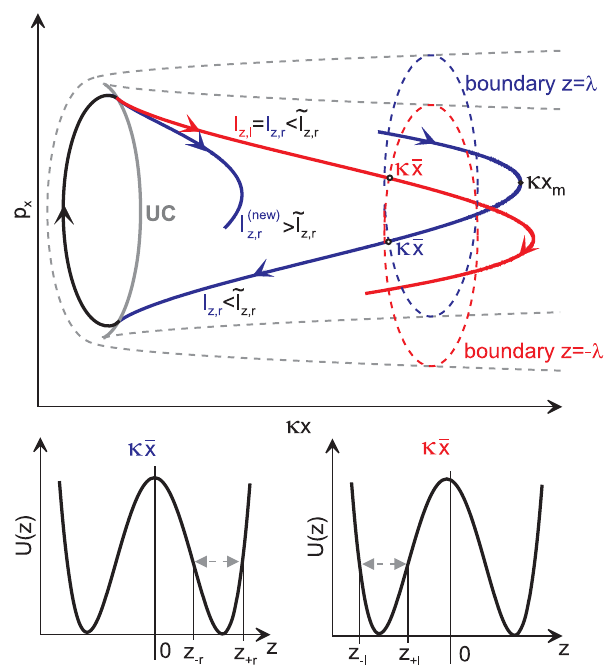
Fig. 2. Schematic view of particle trajectories before and after the neutral plane crossing. The uncertainty curve (UC) is shown by the grey solid line. Bottom panels show profiles of potential energy U(z) and particle positions for two points in the plane (κx,p x ) .